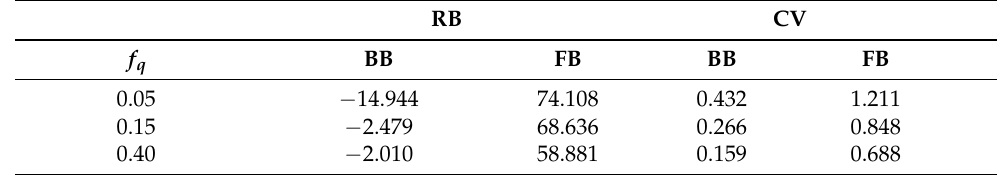
Table 5. Performance indicators for DGP 2 with p =